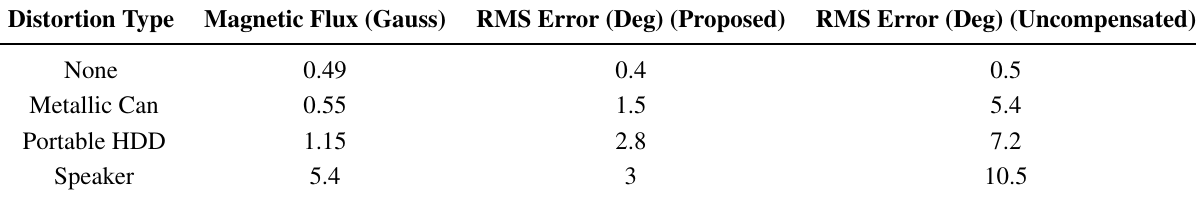
Table 1. The ferrous objects